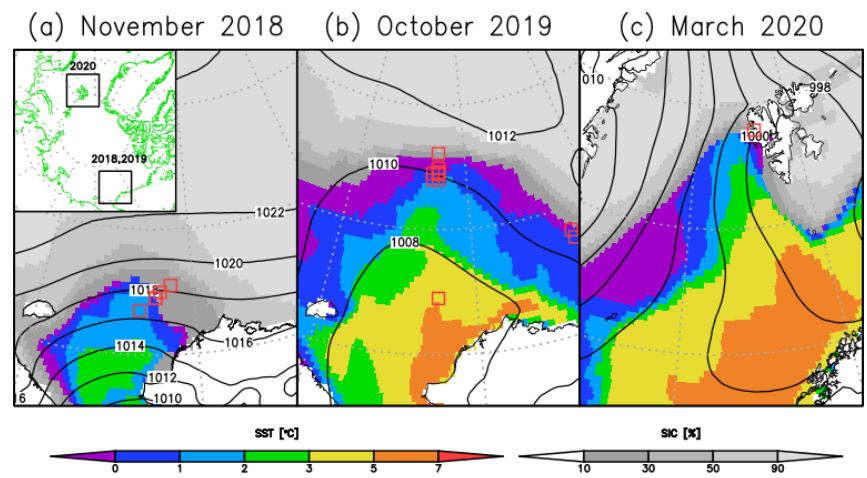
Figure 3. Location of the CPS sondes (red squares) during research cruises in (a) November 2018 and (b) October 2019, as well as (c) a field campaign in March 2020. Monthly mean sea-ice concentration (gray shading), sea-surface temperature (color shading), and sea-level pressure (contours) are based on ERA5 reanalysis.